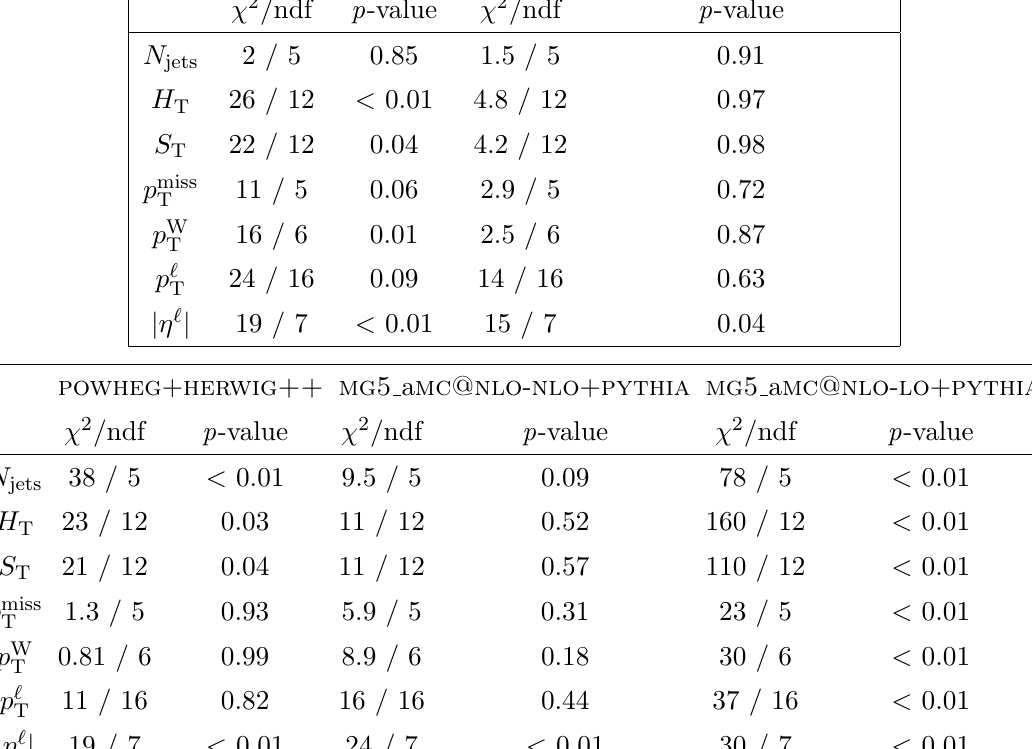
and (cid:17) ‘ distributions for any model when T j j